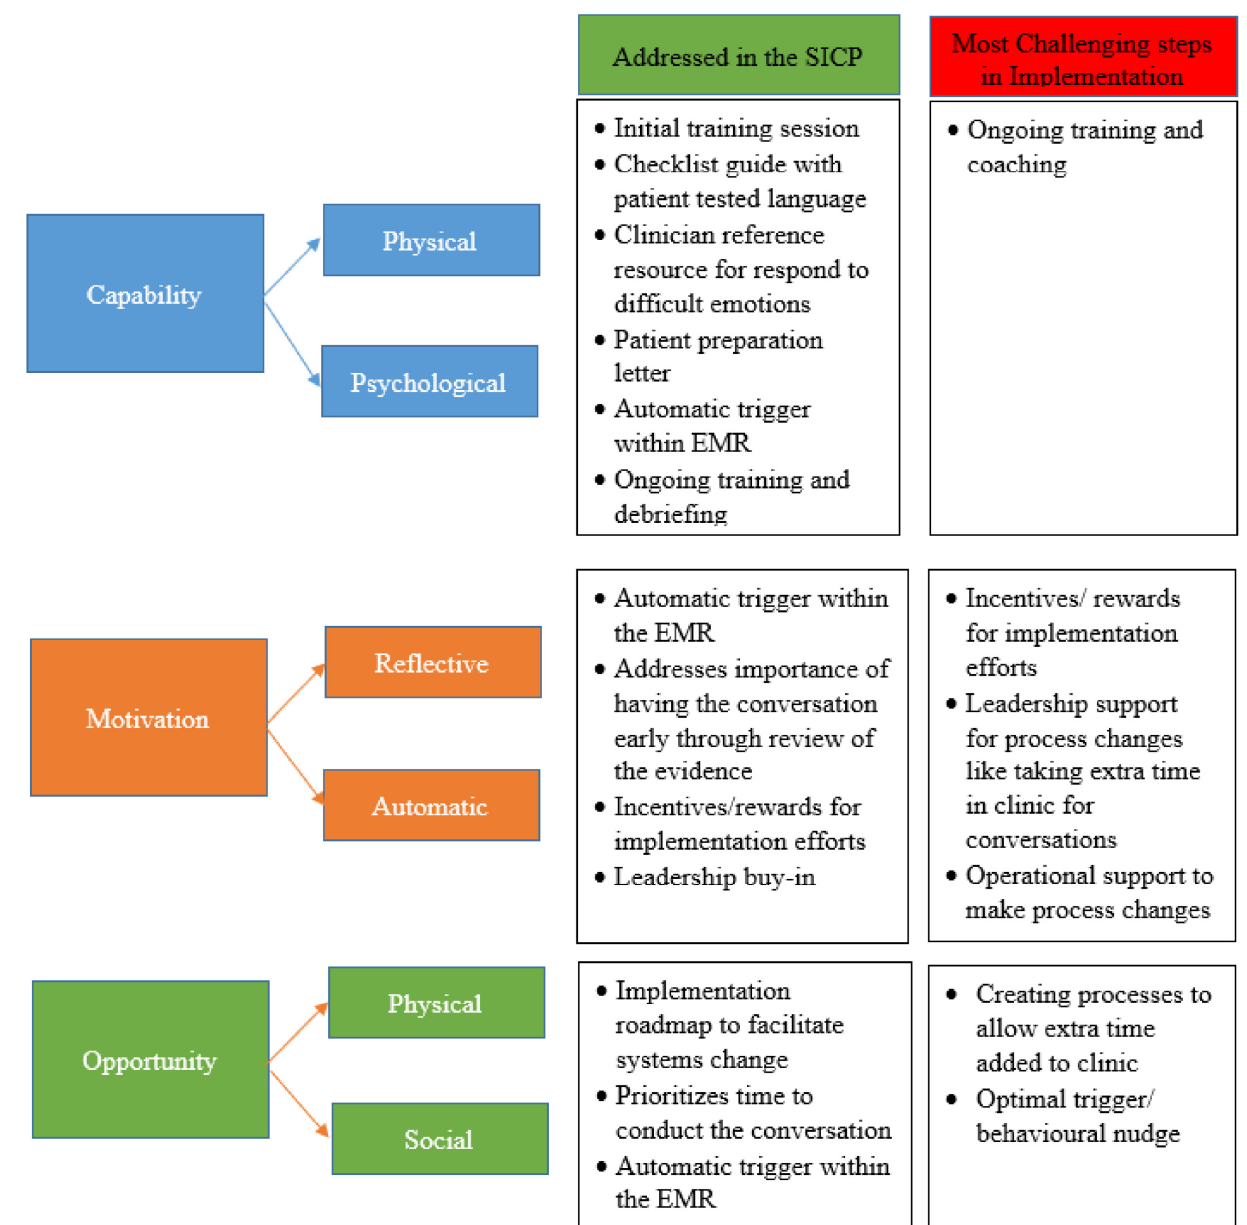
Figure 1. COM-B model components and the